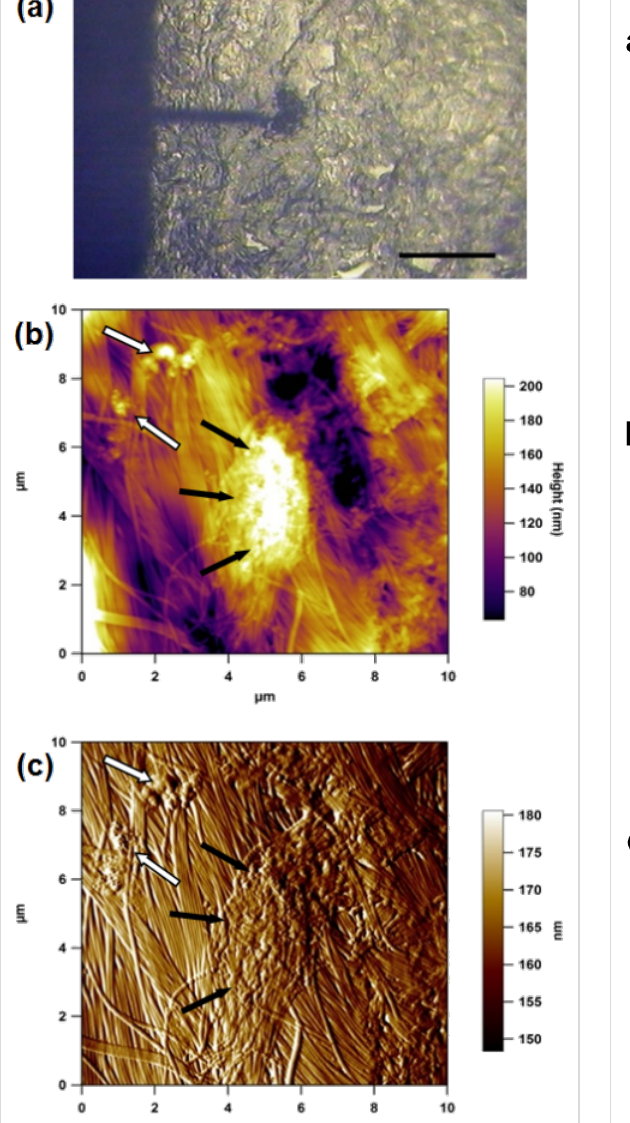
Figure 2: (a) AFM optical image (10×) showing the cantilever over a region of tattoo ink in the dermis; scale bar 200 μ m. (b) 10 μ m AFM height and (c) amplitude (error) image of cryosectioned tattooed skin. Black arrows indicate a large agglomerate and white arrows smaller agglomerates of tattoo ink particles.